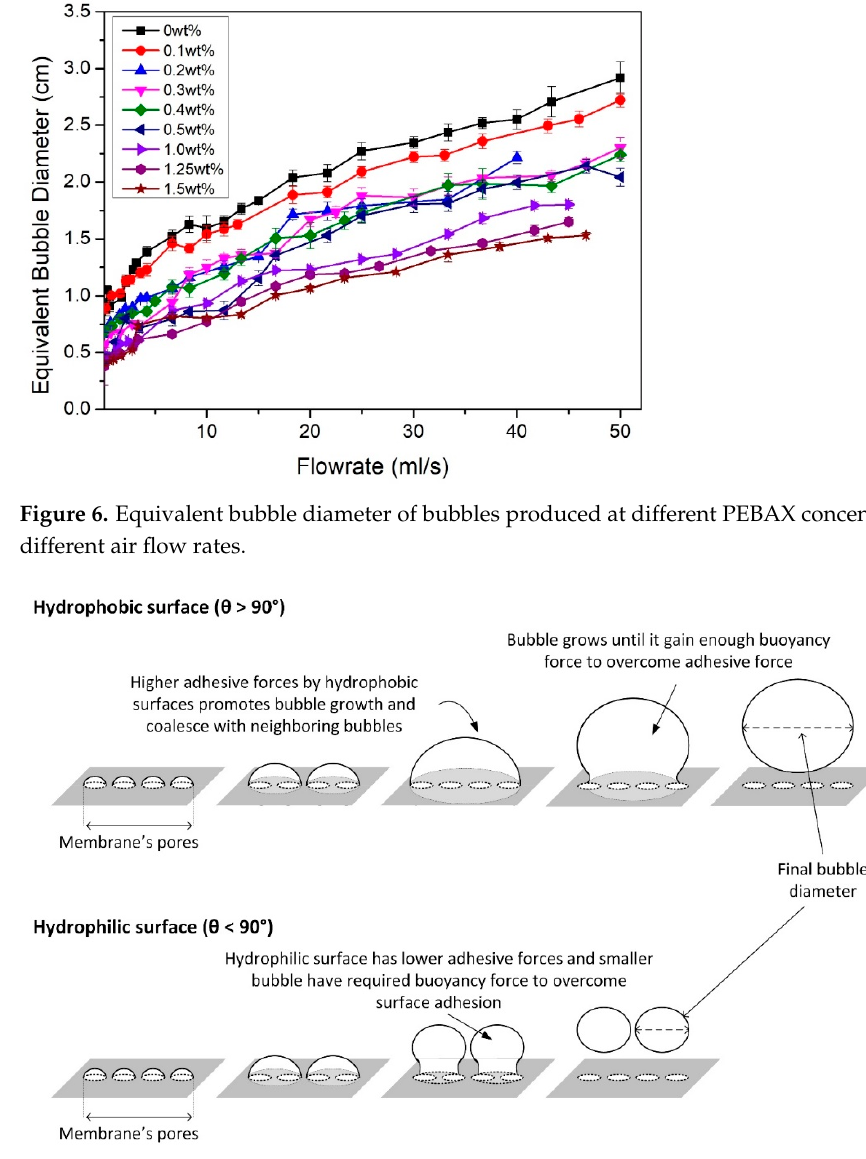
Figure 7. Bubble formation using hydrophobic ( θ > 90 ◦ ) and hydrophilic ( θ < 90 ◦ ) porous membrane surfaces.